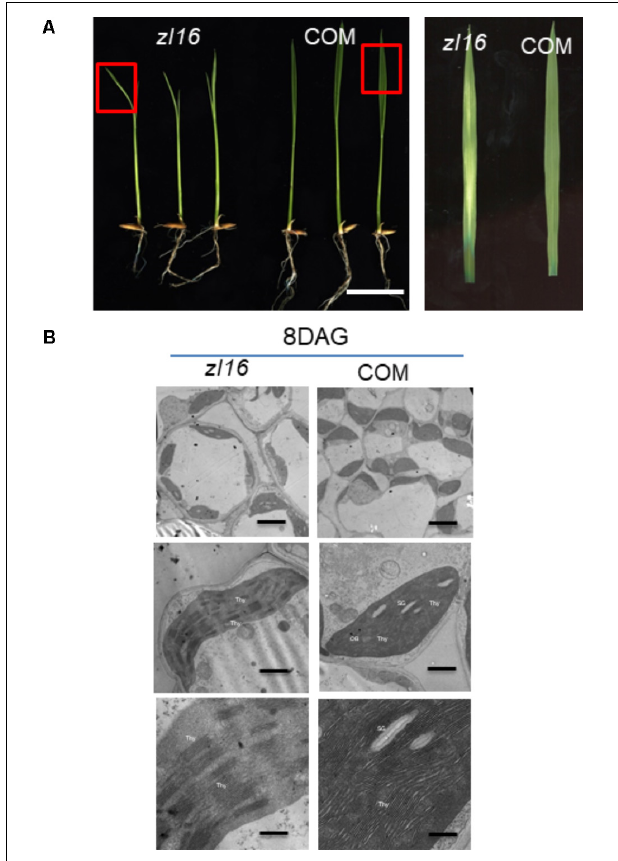
FIGURE 5 | Functional confirmation of ZL16 gene. (A) Genetic complementation. The functional wild-type (WT) ZL16 was inserted in the zl16 mutant genome and zl16 recover to normal green color. “COM” indicates three representative positive complemented plants generated by callus transformation. Bar = 2cm. The boxes in the left panel denote the regions that are enlarged in the right panel. (B) . Transmission electron micrographs (TEM) images of zl16 (left panel) and complemented (COM) plant (right panel) chloroplasts. Seedlings were grown for 8 days after germination. OB, osmiphilic body; SG, starch granule; Thy, thylakoid lamellar. Bars: 2 µ m (top row), 1 µ m (middle row), and 0.5 µ m (bottom row).